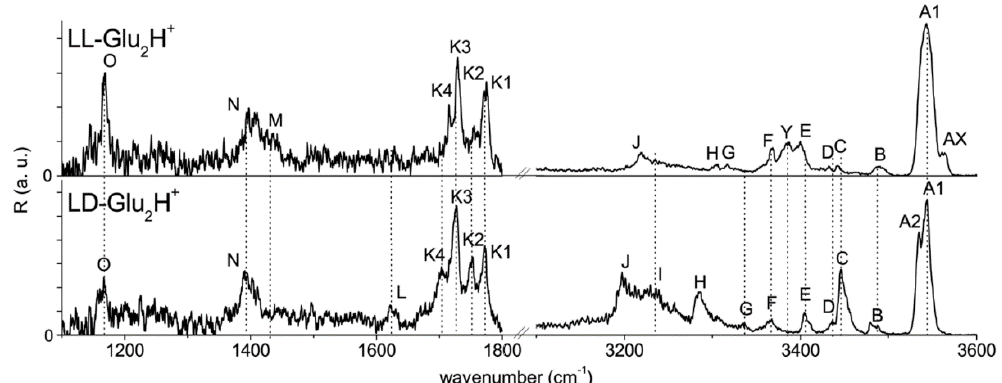
Figure 9. Overview IRPD spectra of diastereospecific ll - ( top ) and ld -Glu 2 H + -H 2 ( bottom ) recorded in the XH stretch (X = O, N; 3100–3600 cm − 1 ) [55]. Reprinted with permission from RSC.